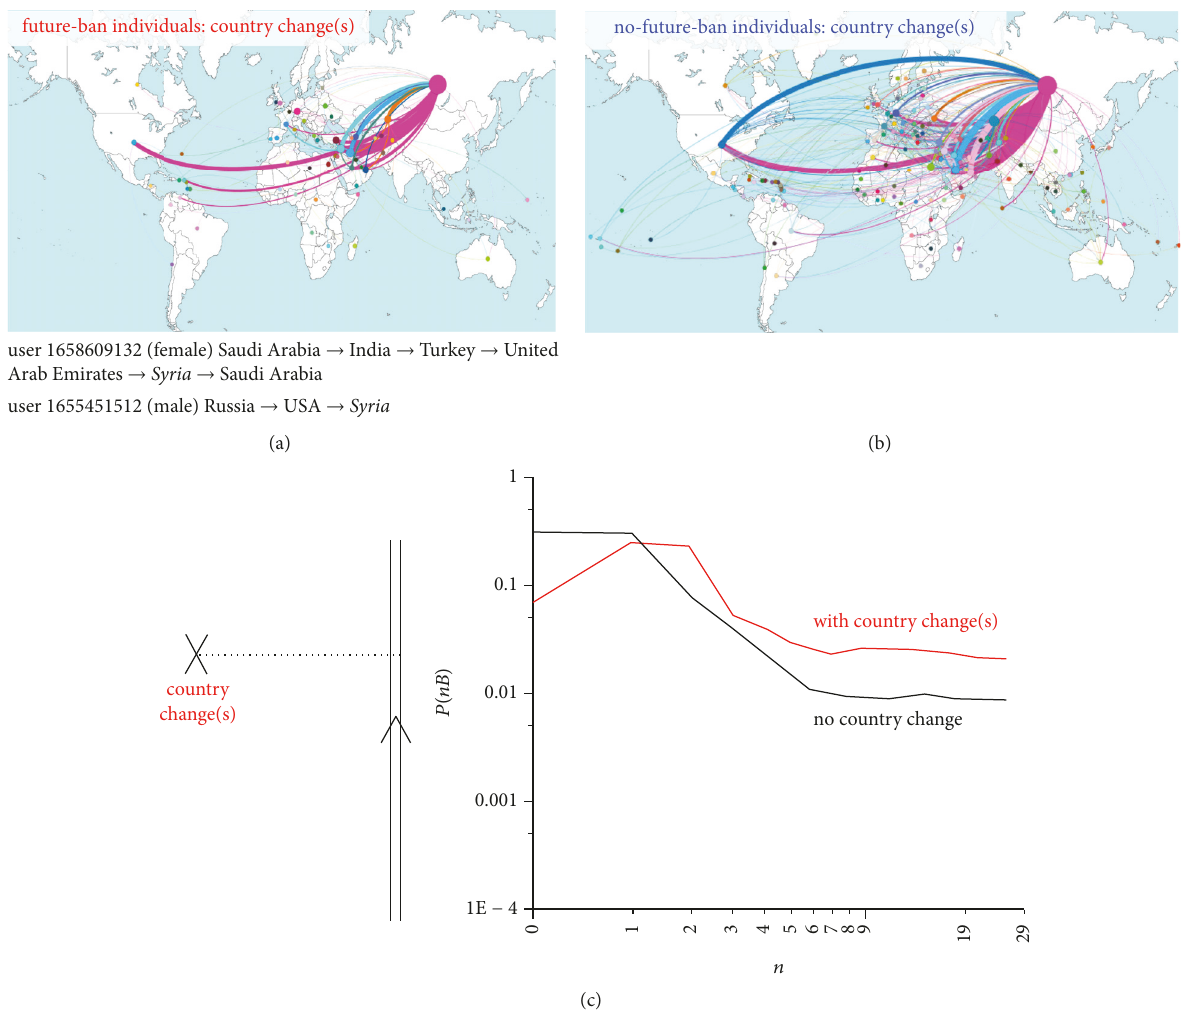
Figure 4: Influence of geography . (a) Flow of future-ban individuals based on reported geographical locations in online profiles. The flow from country X to country Y is the number of individuals that change location from X to Y and is proportional to the thickness of the line. The line color corresponds to the originating country X . Each country’s node is at its geographic centre. Two individuals’ trajectories are listed as examples. Although Russia resembles a travel hub for all individual types because VKontakte has a large number of Russian users, many individuals’ pathways do not pass through it (e.g., user 1658609132). (b) Same as (a) but for individuals whose accounts are not eventually banned (“no-future-ban” individuals). For future-ban individuals (a), this country return rate 𝑟 = 21.6 % while for no-future- ban individuals (b) 𝑟 = 44.7 %, which is more than twice. (c) Scattering between countries is associated with a shift in the dependence of 𝑃(𝑛𝐵) . Red line is for future-ban individuals who changed country at least once. Black line is for future-ban individuals who never changed